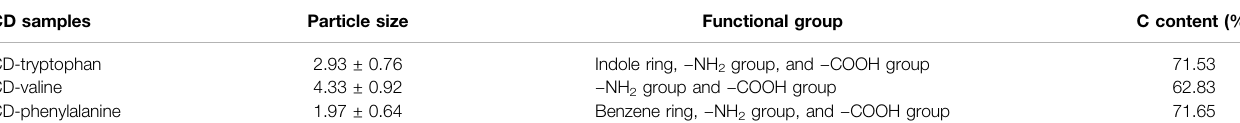
TABLE 1 | Catalytic in fl uence factors from CDs with better catalytic performance.